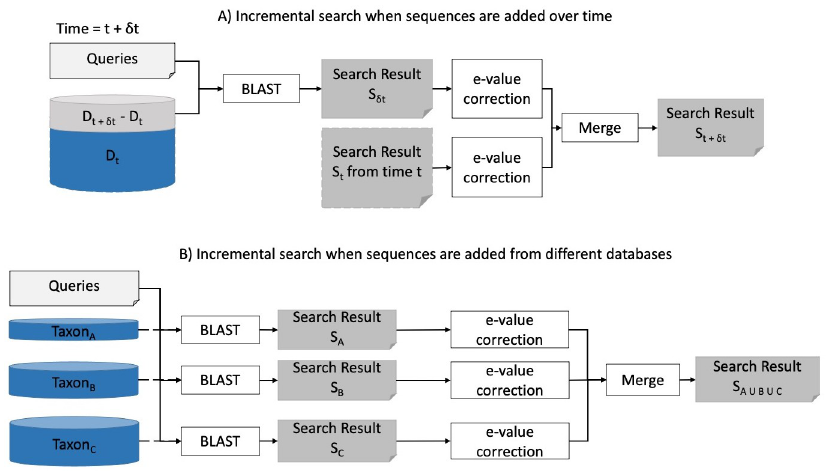
Fig 1. Addition of new sequences. (A) BLAST search when new sequences are added to the database. At time t , the database is D . In next δ t interval, new sequences D are added, and the database becomes D t t + δ t − D t traditional approach, the prior search result at time t cannot be reused, and we have to perform an entire BLAST search against the entire D database. (B) BLAST search when several taxon-specific databases are present and a t + δ t result against the combined database is needed. For three taxa, A, B, and C, we can perform individual BLAST searches against the databases D , D , D , respectively. If we want to obtain a search result against the combined database A B C D A [ B [ C , we need to merge the search results in a way that their e-values reflect the combined database